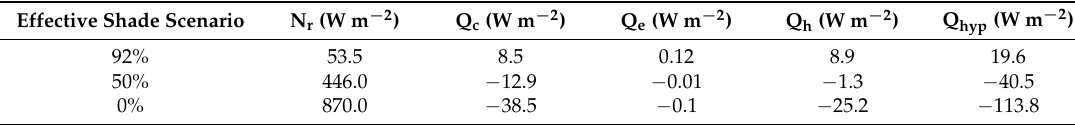
Table 4. Measured net radiation flux (Nr) for open sky, net radiation heat flux adjusted for 50% effective shade and 92% canopy and the associated estimated heat fluxes of streambed conduction (Q c ), latent